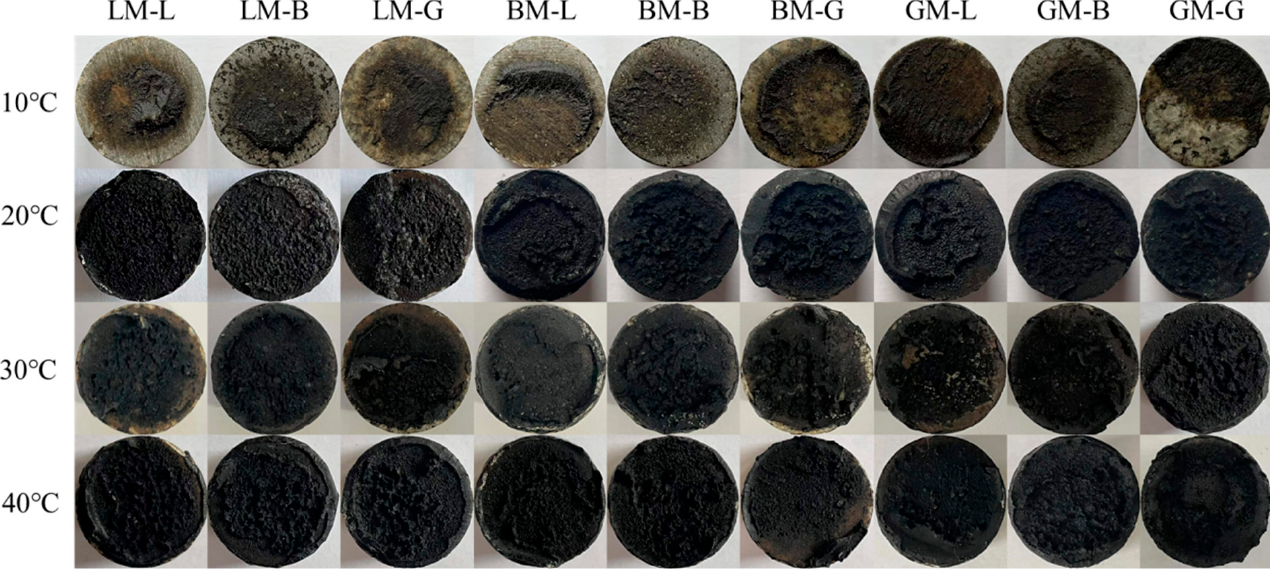
Figure 11. Failure modes of asphalt mortar–aggregate interfaces at different temperatures.